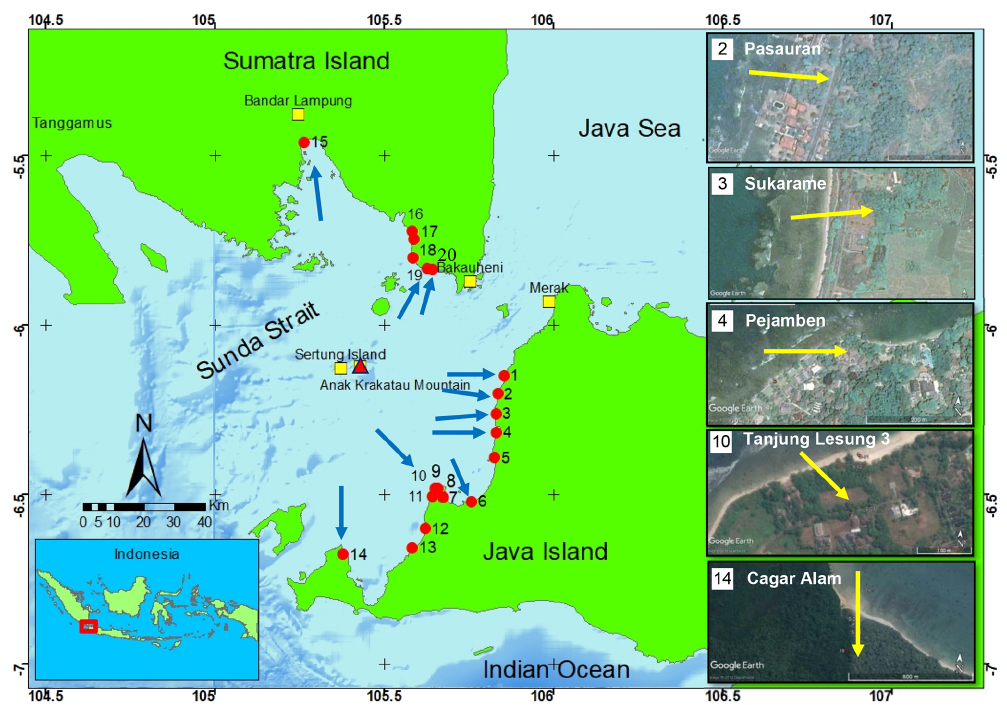
Figure 4. Direction of tsunami propagation; the tsunami spread radially from its source. Numbers next to red dots and in images are survey